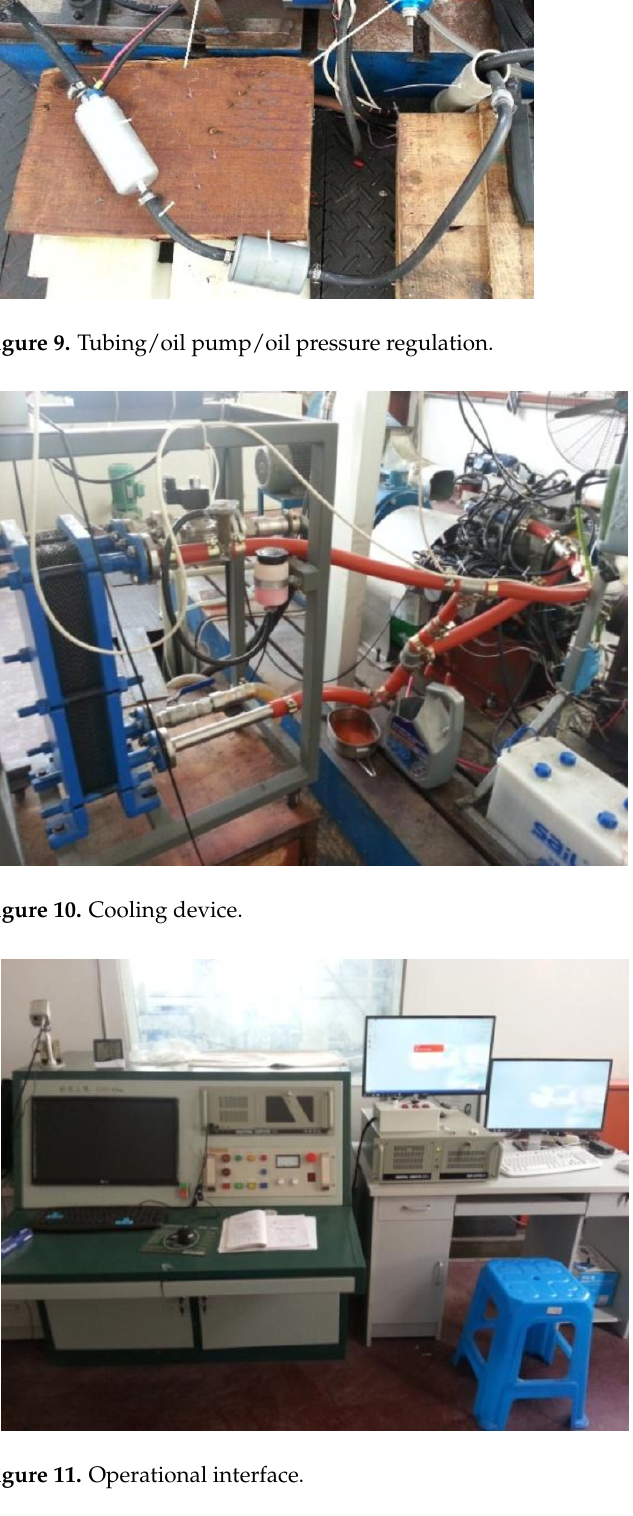
8 of 23 Figure 7. Engine bench site.